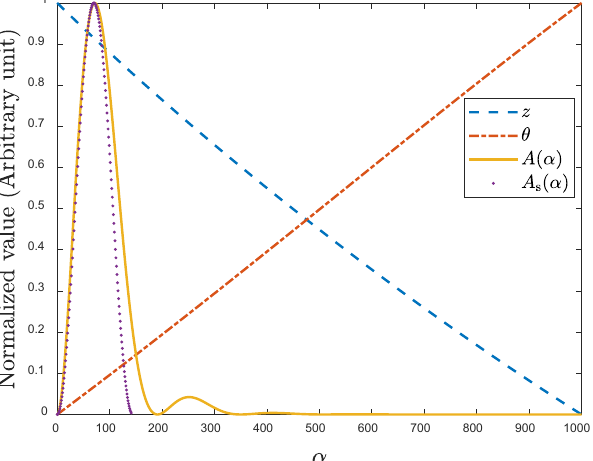
Figure 2. Comparison between the plate term φ ( α ) = ze i θ and sensor term A ( α ) together with its approximation function A s ( α ) .